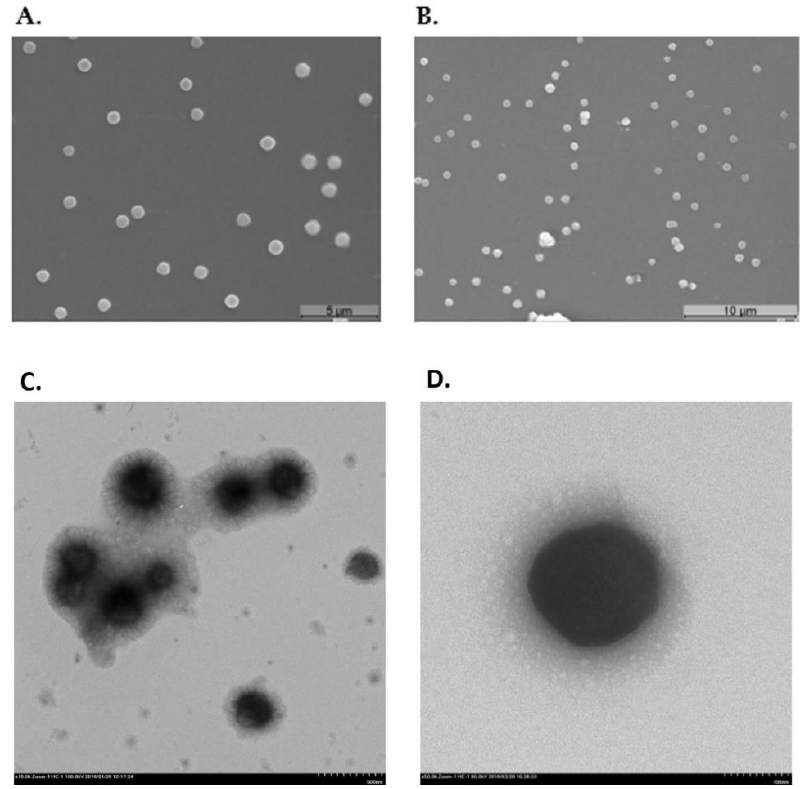
Figure 3. ( A , B ) Scanning electron micrographs of CS-TPP-pDNA NPs at magnification of 5000× and 3500×, respectively. ( C , D ) Transmission electron micrographs of CS-TPP-pDNA